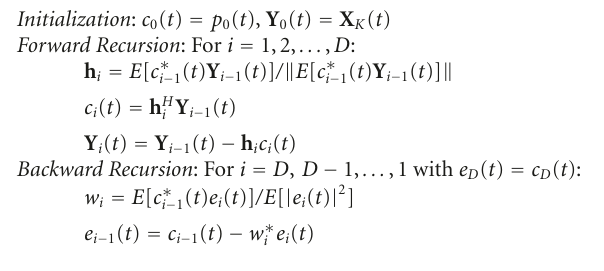
Algorithm 2: CSS-MWF algorithm